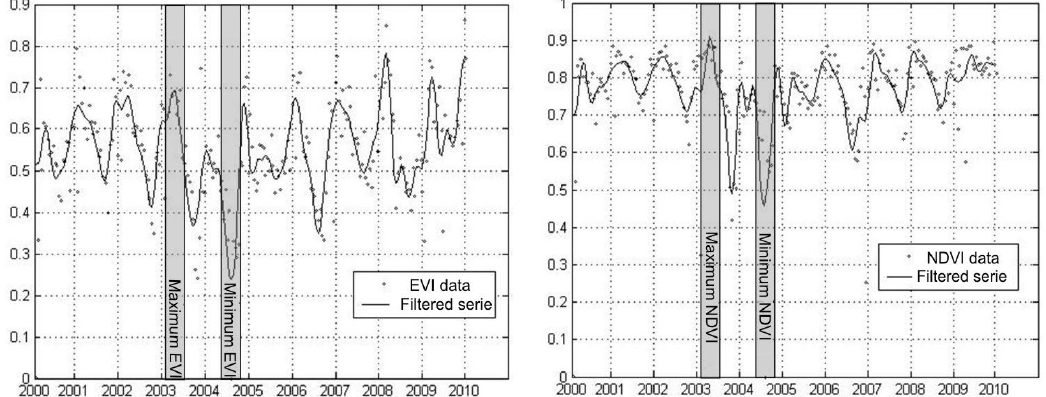
Figure 5. Filtered EVI and NDVI time series for coffee crop and the original data (without filtering process).